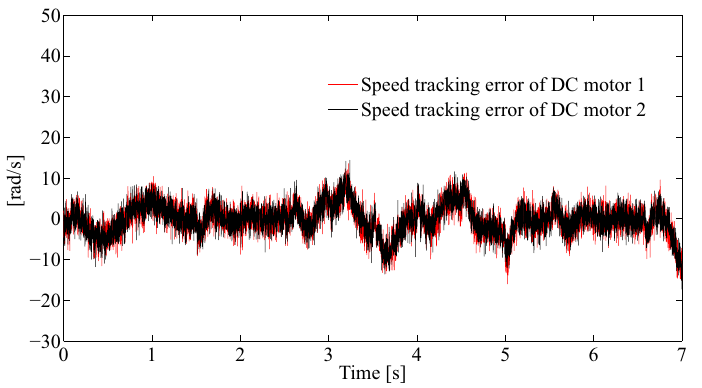
Figure 8. Angular speed tracking error responses.